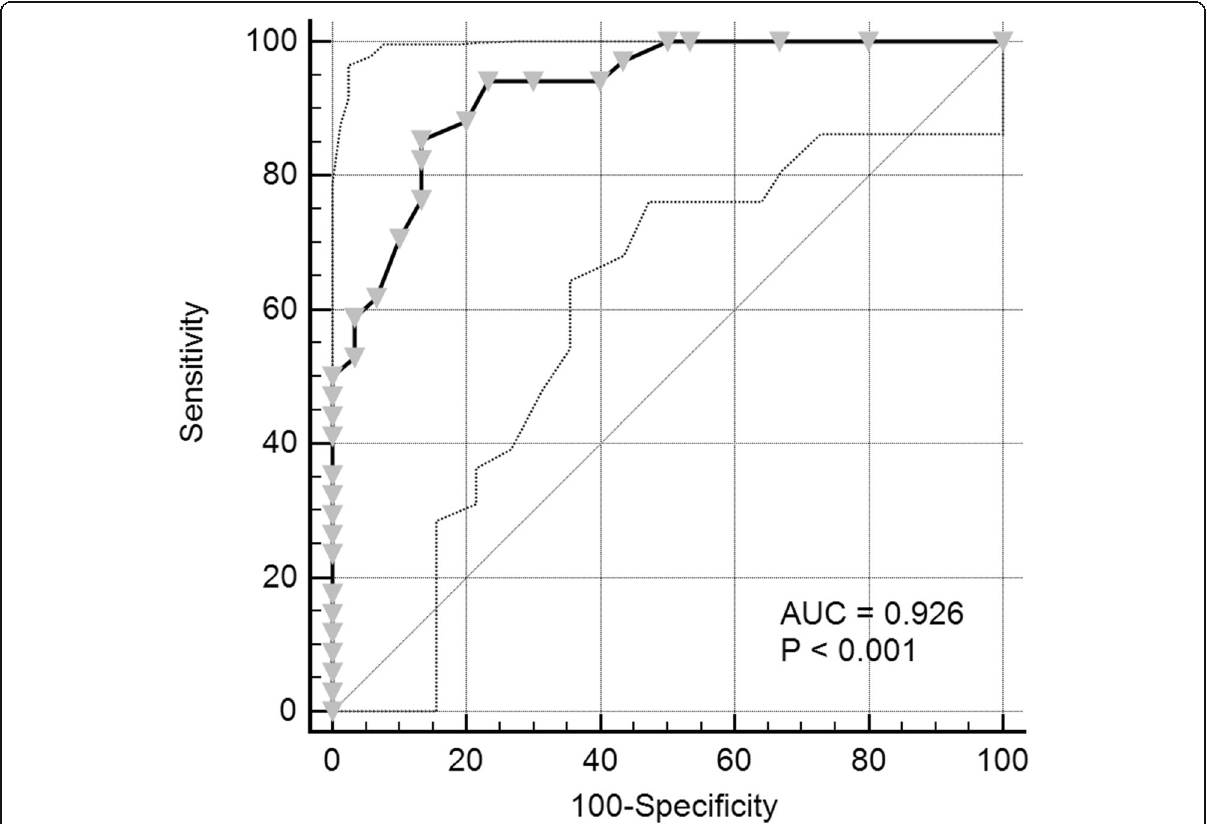
Fig. 2 ROC curves were calculated for revealing a high FLT3 ITD burden using AF as determined by NGS. A high FLT3 ITD burden was indicated by an AR value of greater than 0.5 by fragment analysis. By applying the cutoff value of 0.11, the AUC was 0.926 (95% CI: 0.833 – 0.977). ROC curve (solid line) with 95% confidence interval (dashed lines). The dotted line is a diagonal